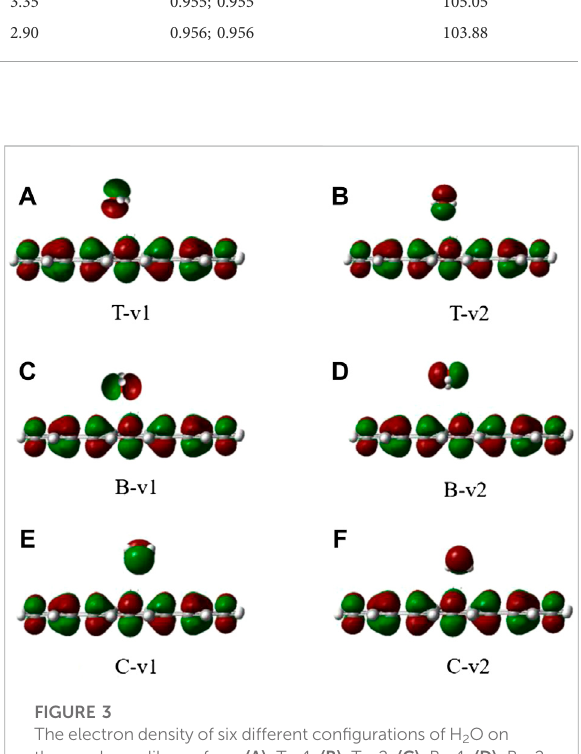
FIGURE 3 The electron density of six different con fi gurations of H 2 O on the graphene-like surface. (A) : T-v1, (B) : T-v2, (C) : B-v1, (D) : B-v2, (E) : C-v1, (F) : and